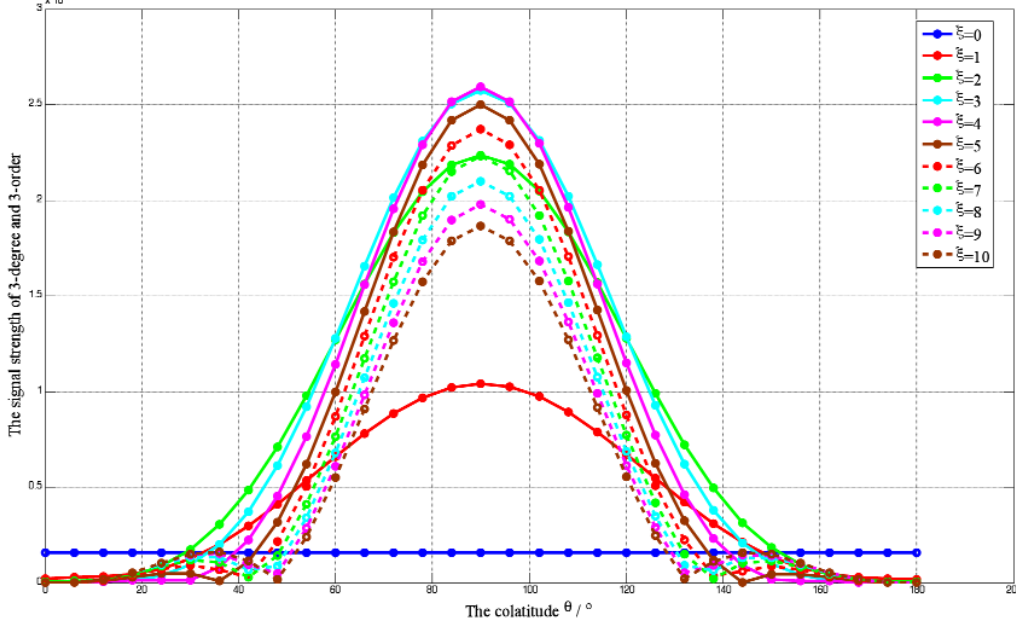
Figure 7. The signal strength of third-degree and third-order spherical harmonics at different co-latitudes (longitude, m = r